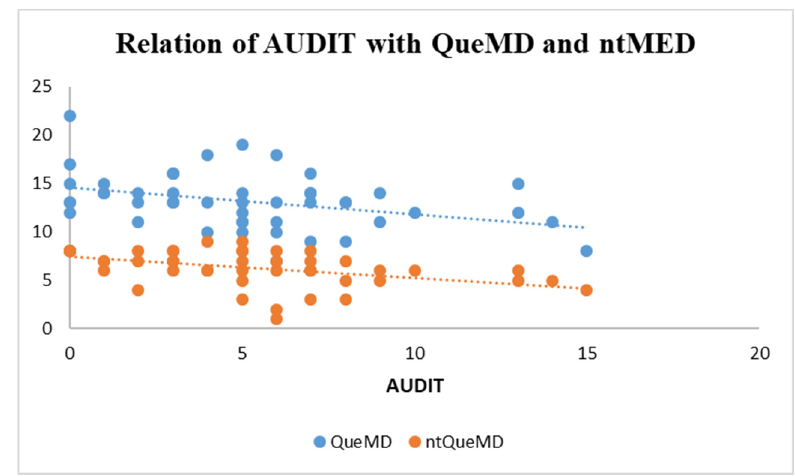
Figure 3. Linear regression between AUDIT score and adherence level to the Mediterranean diet according to QueMD questionnaire and the sub-score ntMED, in the Spanish sample. AUDIT: Alcohol use disorders identification test; QueMD: Questionnaire to measure Mediterranean diet; ntMED: non-typical MD foods score. AUDIT versus QueMD: blue trendline; equation: y = − 0.2789x + 14.612; R squared: 0.137; 95% CI: − 0.489 to − 0.069; p < 0.05; AUDIT versus ntMED: orange trendline; equation: y = − 0.2172x + 7.421; R squared: 0.201; 95% CI: − 0.347 to − 0.087; p < 0.01.